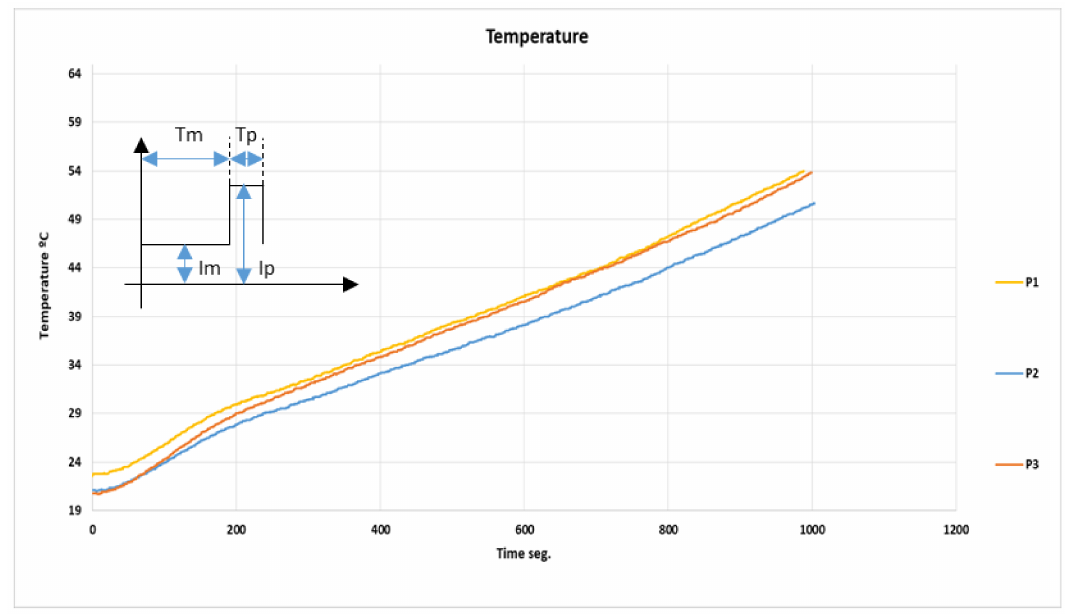
Figure 3. Battery temperature for several discharge